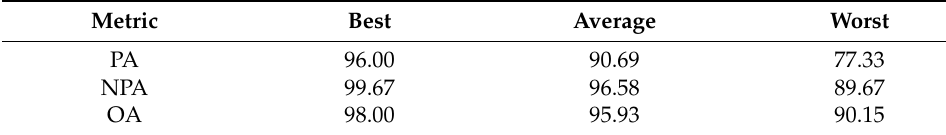
Table 4. Unauthorized PV detection result by method in [39].